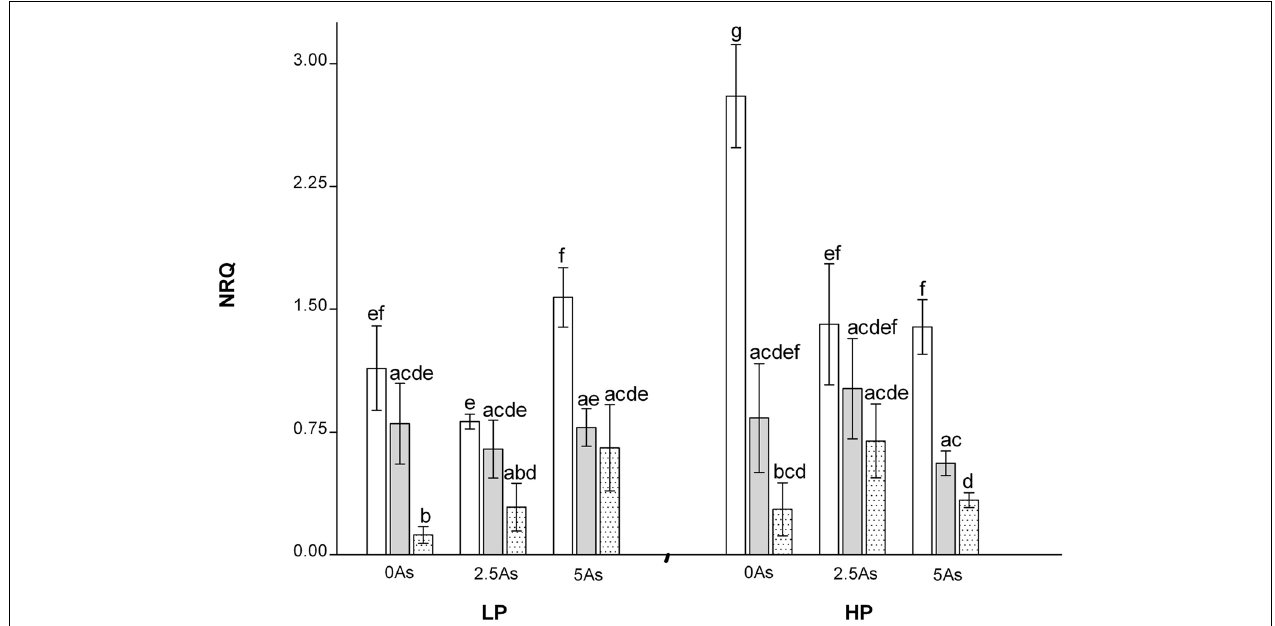
at rates of 2.5 and 5mgAskg − 1 soil (2.5As and 5As, respectively). Data are presented as mean values ± SEM ( n = 5, except for treatment group NM, HP5As where n = 3).The interaction between all factors (P, As, and inoculation) was significant ( P = 0.045). Same letters indicate no significant difference between treatment groups at the 5% level.